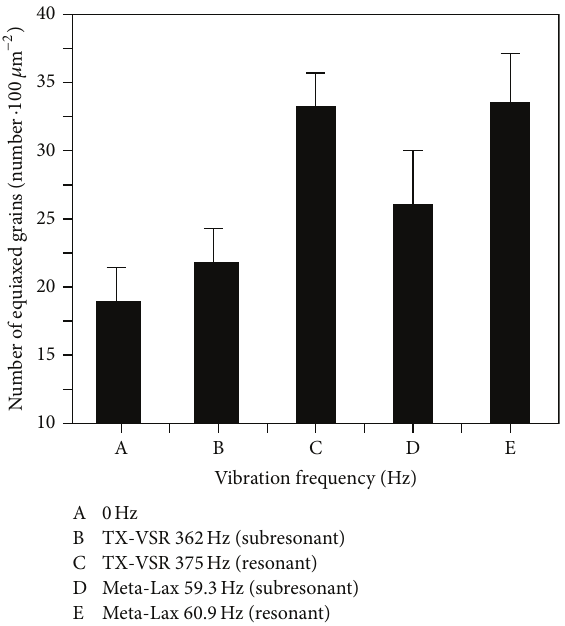
Figure 9: The amount of the equiaxed grain in the welds.